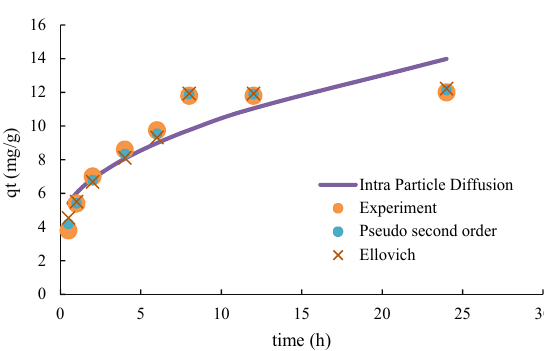
Fig. 5: Adsorption kinetic for wastewater organic compounds on sodic soil